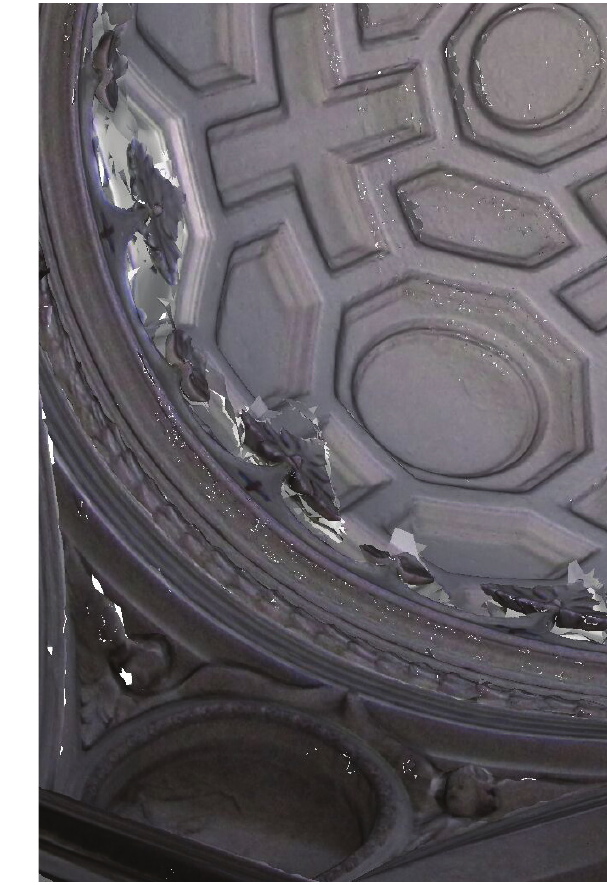
Figure 1. The San Carlo alle Quattro fontane vault. Figure 2. Range based